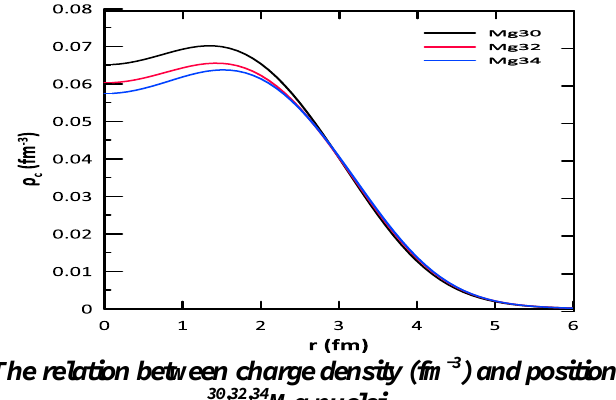
Fig. 4(b): The relation between charge density (fm -3 ) and position r(fm) for 30,32,34 Mg